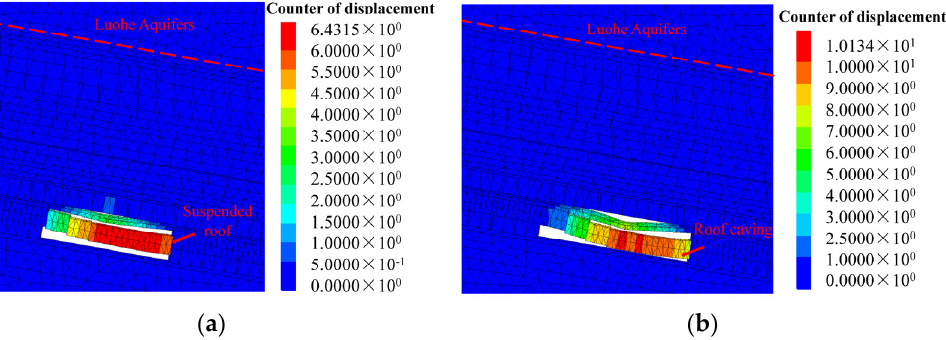
Figure 7. Roof caving process by conventional mining at the length of ( a ) 60 m and ( b ) 70 m, respectively.